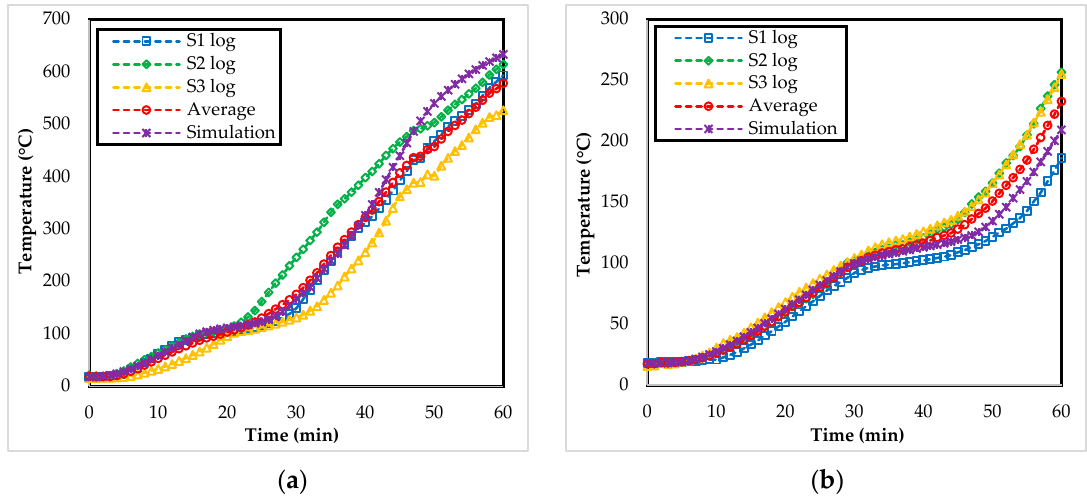
Figure 9. Temperature profile: ( a ) depth of 40 mm (logs); ( b ) depth of 60 mm (logs).